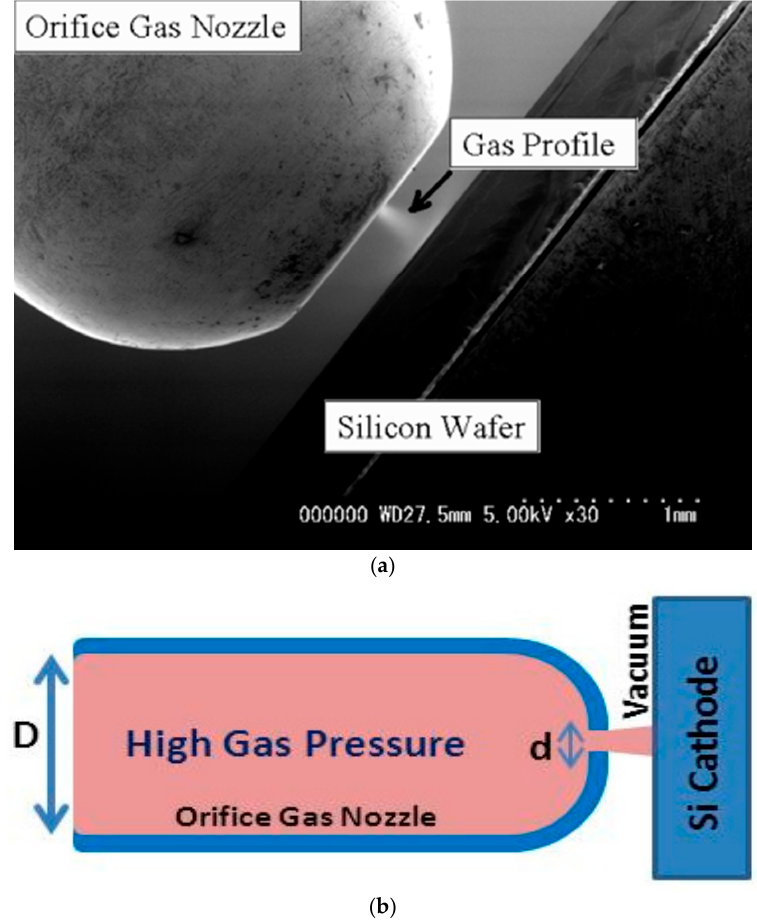
Figure 2. ( a ) An SEM image for the OGN and Si wafer with an image of C 2 H 2 micro gas jet and ( b ) a schematic drawing for OGN. ( b ) a schematic drawing for